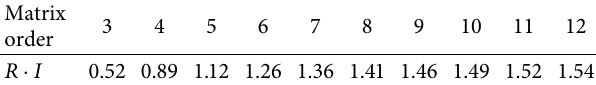
Table 1: Values of randomness indicators.